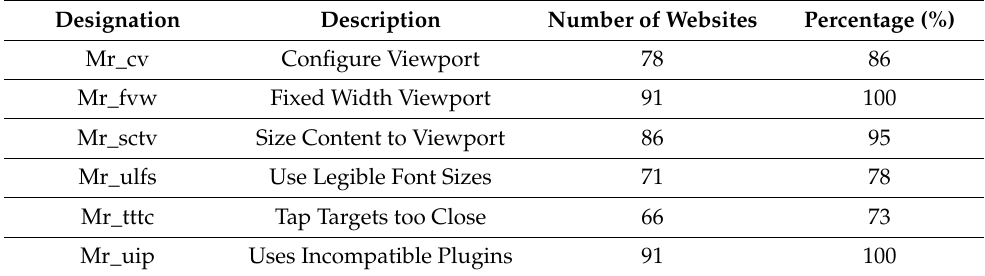
Table 5. Results of Google PageSpeed Insights (PSI) performance tests. Test Range